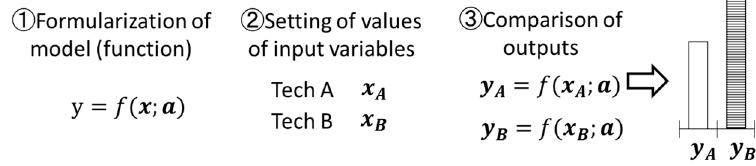
Figure 1. Conventional LCI procedure.